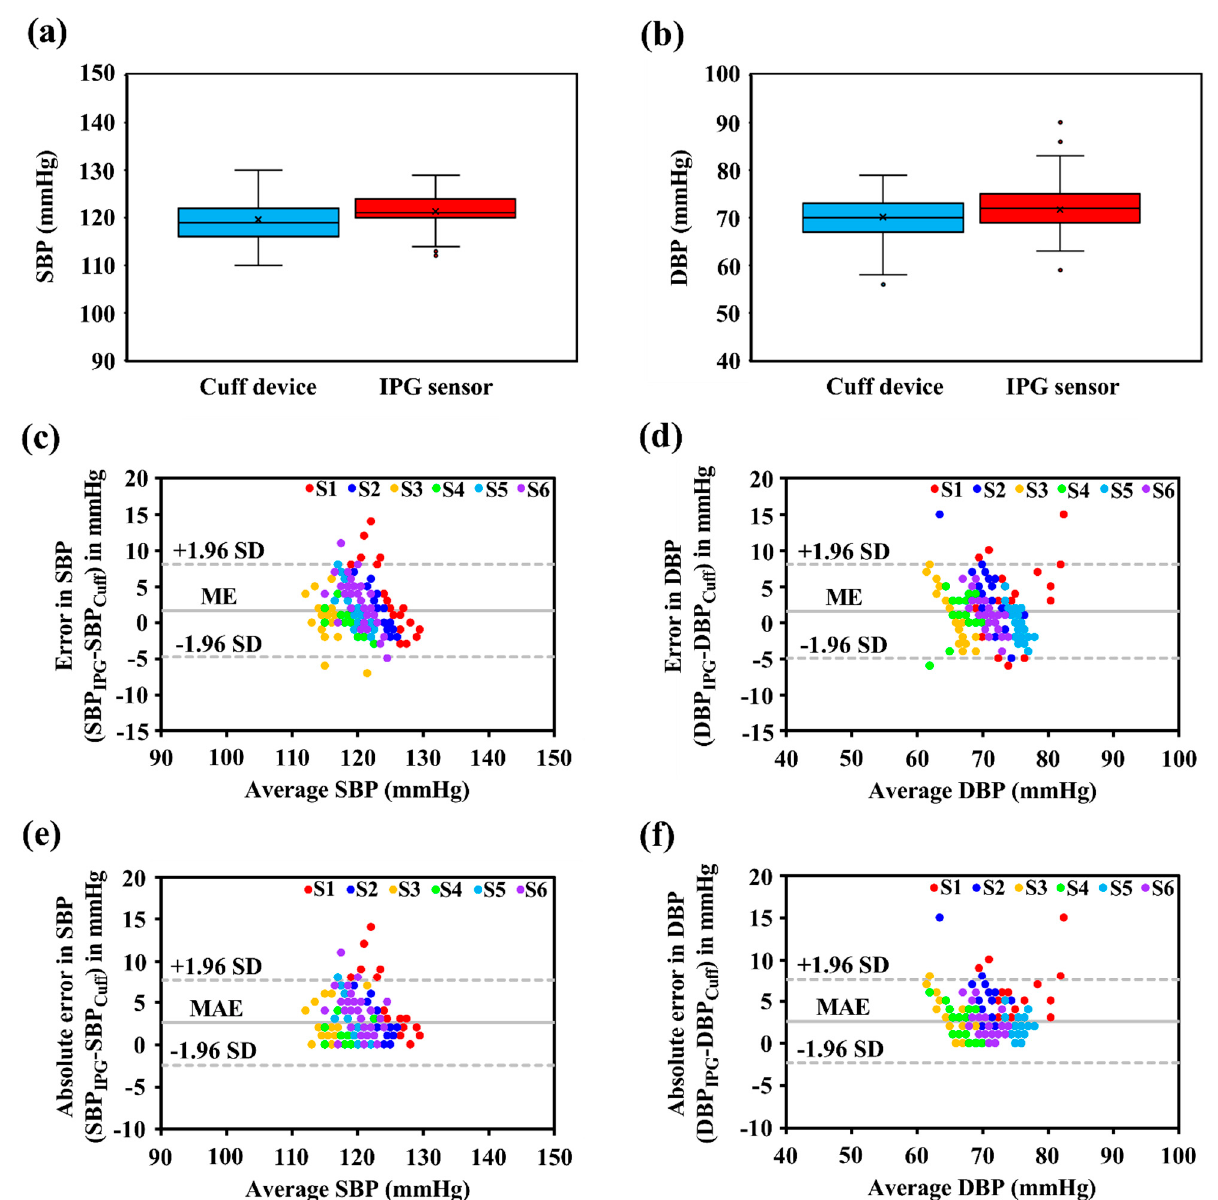
Figure 5. ( a ) IPG signals from a carotid artery for 30 minutes’ measurement. ( b ) Five consecutive IPG waveforms before and after the operating time of the cuff device. ( c ) IPG signal segmentation and further continuous wavelet transform.